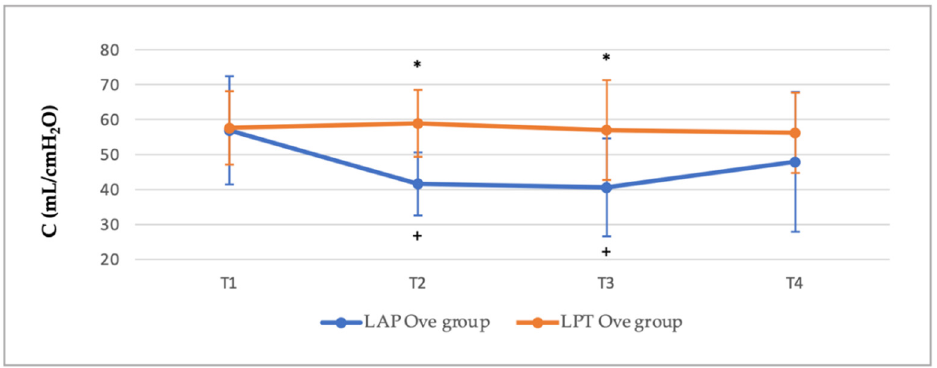
Figure 2. Compliance (C) values at different points in time along the experimental period. Values given as a mean ± SD . p < 0.05: * vs. the LAP Ove group at the same time; + vs. T1 within the same Ove group.